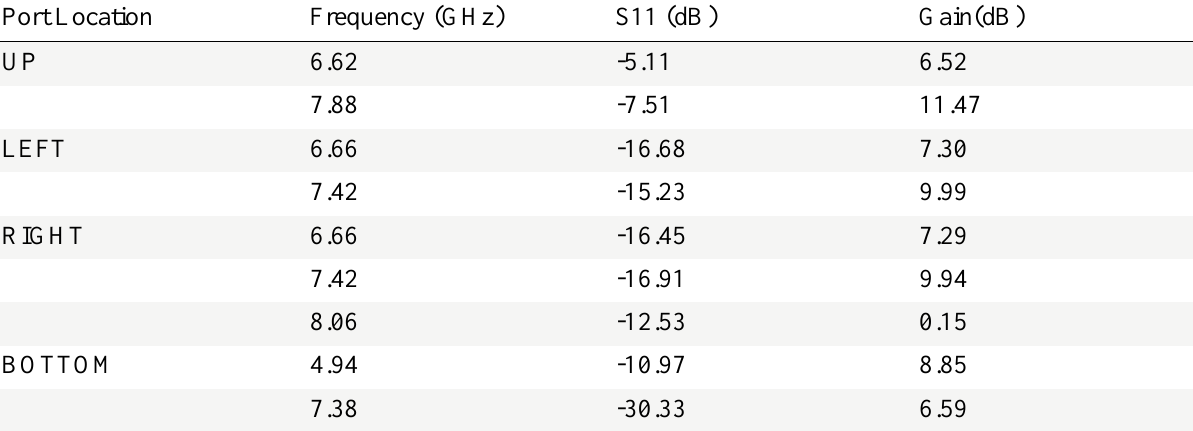
Table 5. Changing port location